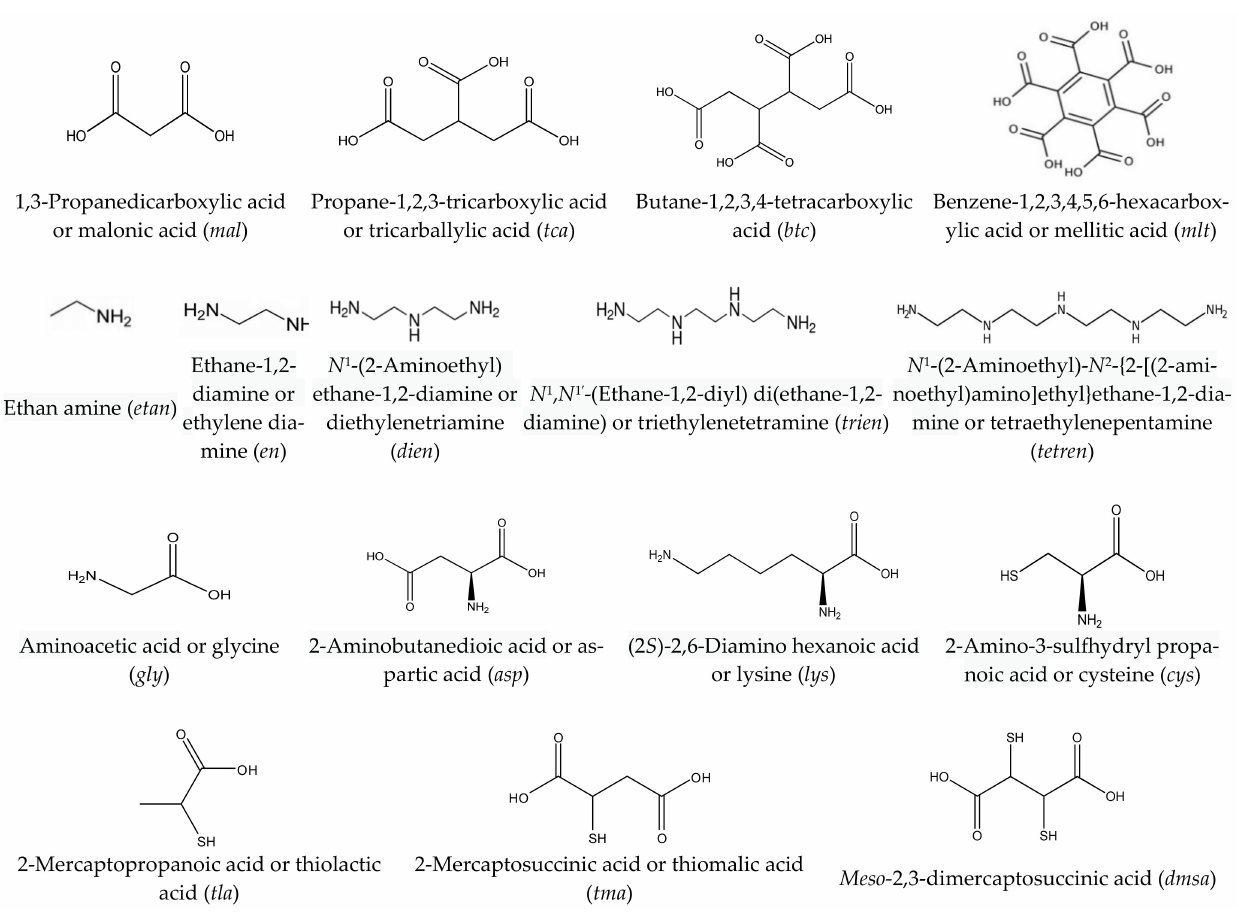
Figure 1. Ligands under